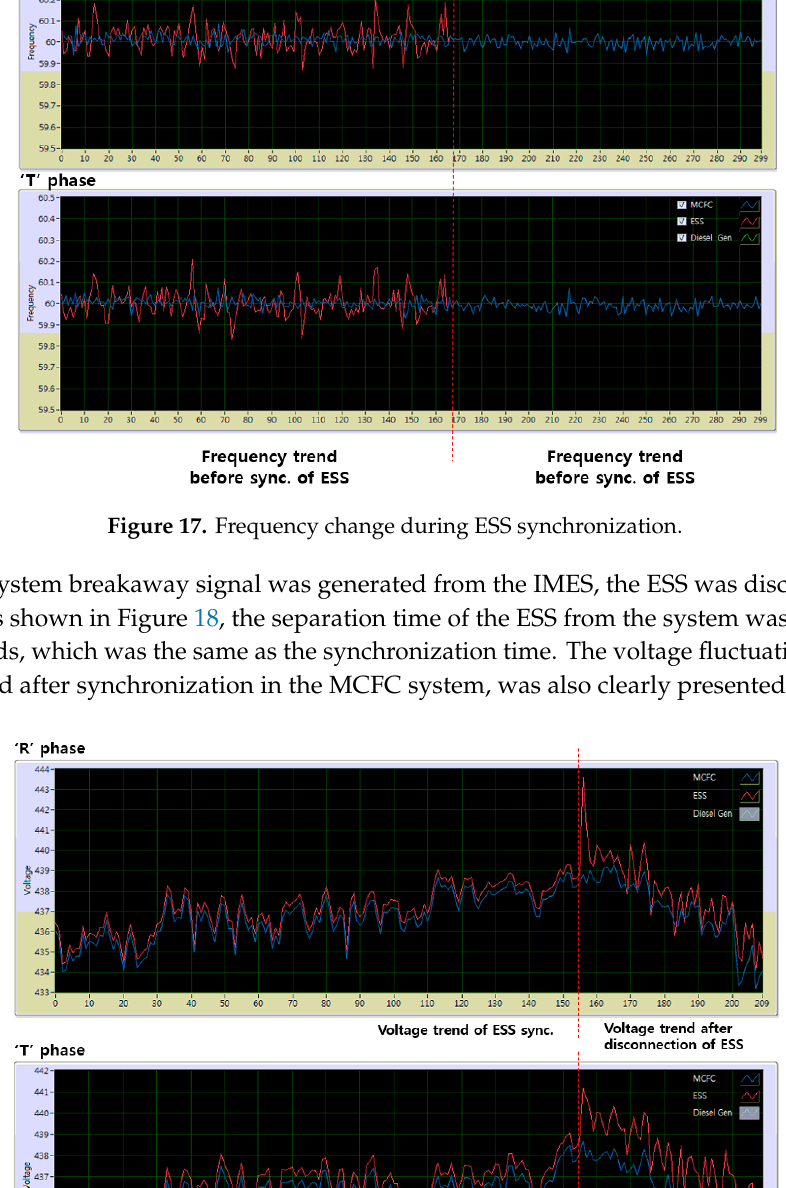
Figure 16. Voltage change during ESS synchronization.